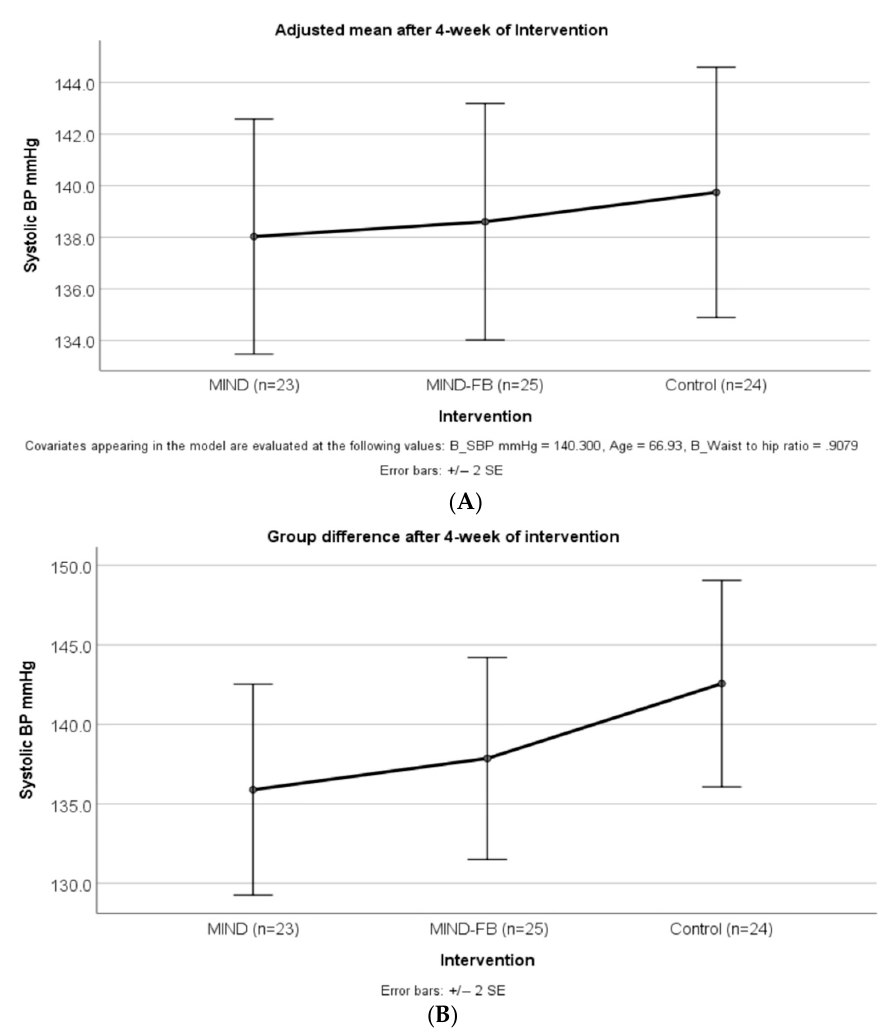
Figure 3. Comparison of means and 95% CI for SBP using an ANCOVA model after 4-week-intervention. The results were adjusted for age, waist to hip ratio, and pre-intervention BP. ( A ) showed the differences of SBP ( p = 0.888) between MIND and MIND_FB groups and the control group were non-significant. ( B ) showed the difference of SBP ( p = 0.339) between MIND and MIND_FB groups, and the control group was non-significant. SBP = systolic blood pressure; MIND group = The Mediterranean-DASH Intervention for Neurodegenerative Delay diet group; MIND-FB group = The Mediterranean-DASH Intervention for Neurodegenerative Delay (MIND) diet plus forest bathing group.